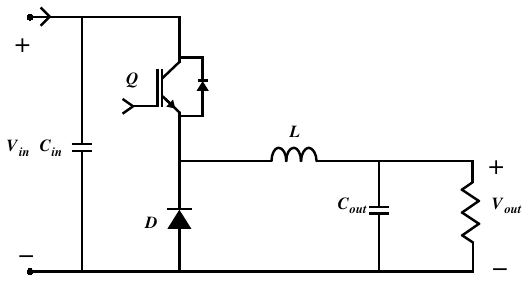
Figure 6. Buck converter schematic. Table 3. Buck converter specifications.